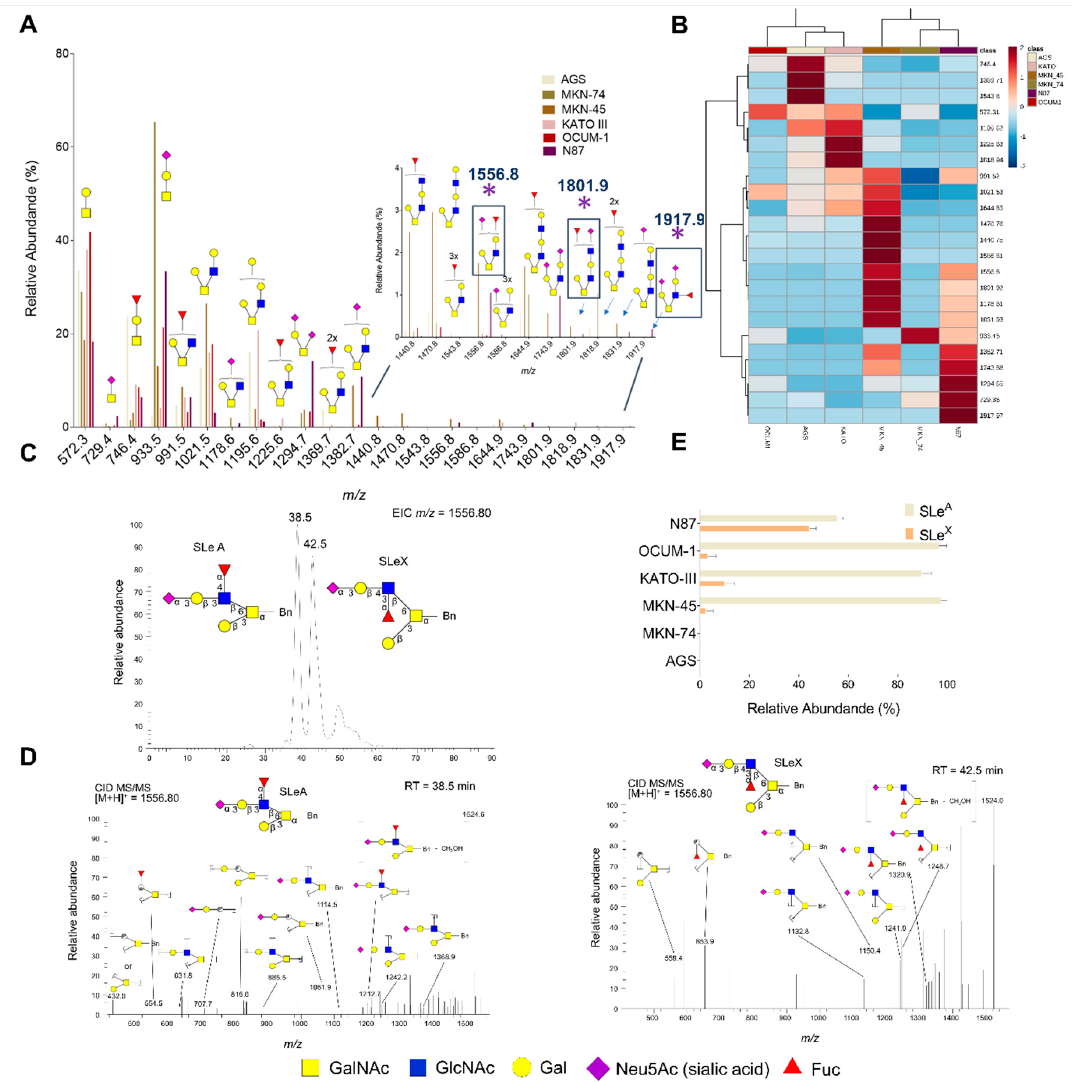
Figure 2. O-Glycomics analysis of GC cells. ( A ) Glycome of GC cell lines. The graph shows that the O-glycome of all cell lines was composed by fucosylated and / or sialylated core 1 and core 2 O-glycans. Additionally, shorter glycans predominated over extended structures beyond core 2. All cell lines, irrespective of their origin, overexpressed T (m / z 572.3), fucosyl-T ( m / z 746.4), ST ( m / z 933.5) and short core 2 ( m / z 1021.5; 1195.6) antigens as main O-glycans. ( B ) Heat-map and cluster analysis detailing di ff erences and similarities between the gastric cancer models. Notably, cell lines MKN-45, KATO-III, OCUM-1 and N87 also exhibited low abundant ions ( < 5% relative abundance; m / z 1556.8, 1801.9 and 1917.9) potentially corresponding to glycans with terminal SLeA epitopes, supporting flow cytometry analysis. ( C ) Typical nanoLC-ESI-MS / MS chromatographic profile of the N87 cell line showing the co-expression of SLeA and SLeX antigens. ( D ) Fragmentation spectra for the ions at m / z 1556 at di ff erent retention times (RT: 38.5 min for SLeA; 42.5 min for SLeX). Panel D shows one possible fragment for each main assignment, considering a mass accuracy of m / z 0.8 and glycosidic cleavages, loss of the benzyl tag and / or cross-ring fragmentations. Diagnostic signals for SLeA result from di ff erent cross-ring cleavages (0,3X, 1,3X or 3,5X) at GlcNAc residues ( m / z = 554.5, m / z = 707.7, m / z = 815.6 and m / z = 1061.9). The fragment ion at m / z = 653.9 (Z3,5XGlcNAc), not observed for SLeA), defined SLeX Several other non-assigned fragments corresponding to multiple combinations of fragmentations (glicosydic plus cross-ring fragmentations) could also be observed. ( E ) Relative abundance of SLeA in relation to SLeX by nanoLC-ESI-MS. According to chromatographic profile showed in panel C, abundance of SLeA was estimated in comparison to SLeX, considering the ion at m / z 1556.8. AGS and MKN-74 did not express SLe epitopes in O-glycan chains, whereas all the other cell lines overexpressed both SLeA and, in much lower amount,